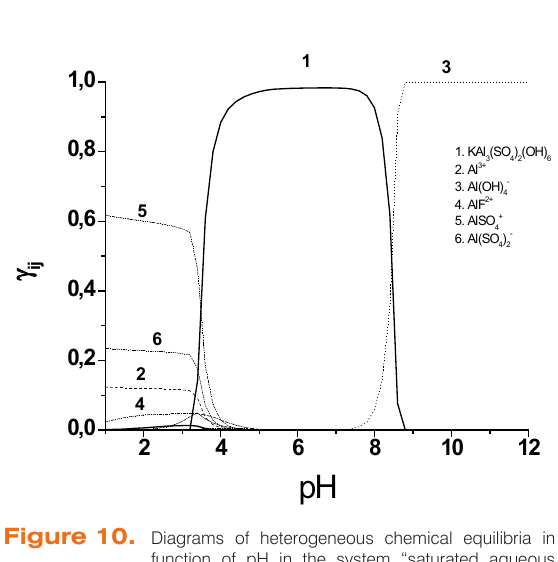
Figure 10. Diagrams of heterogeneous chemical equilibria in function of pH in the system “saturated aqueous solution – alunite”. Concentrations (mol L -1